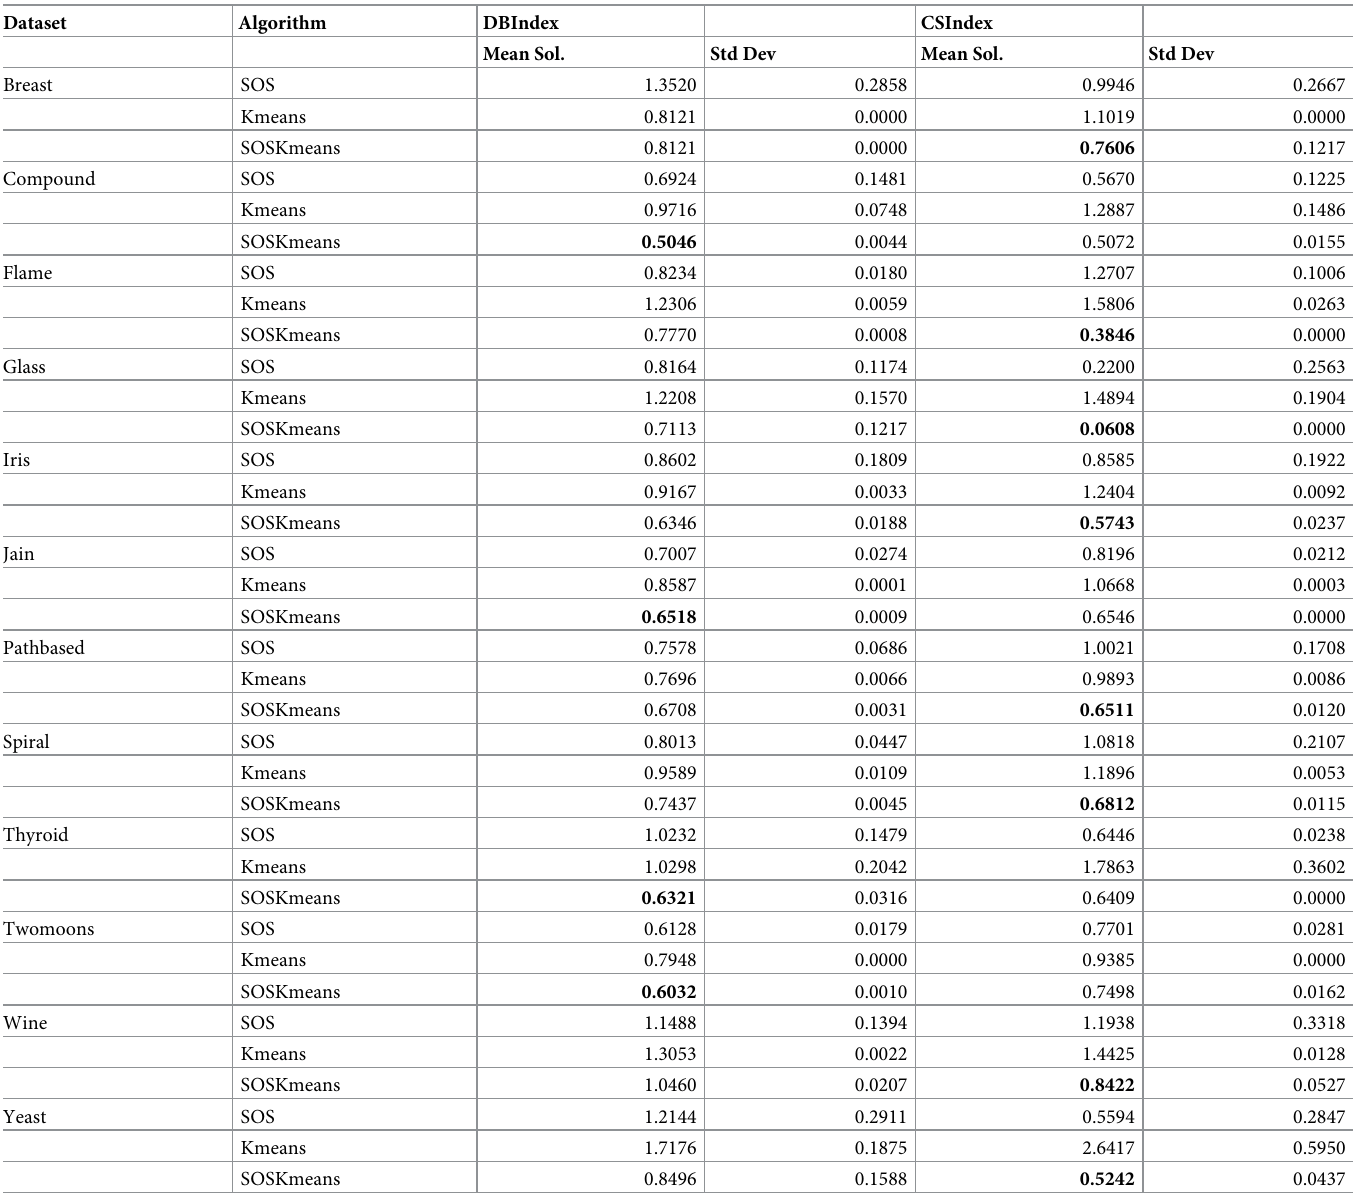
Table 6. SOSK-means compared with SOS and K-means for forty replications.